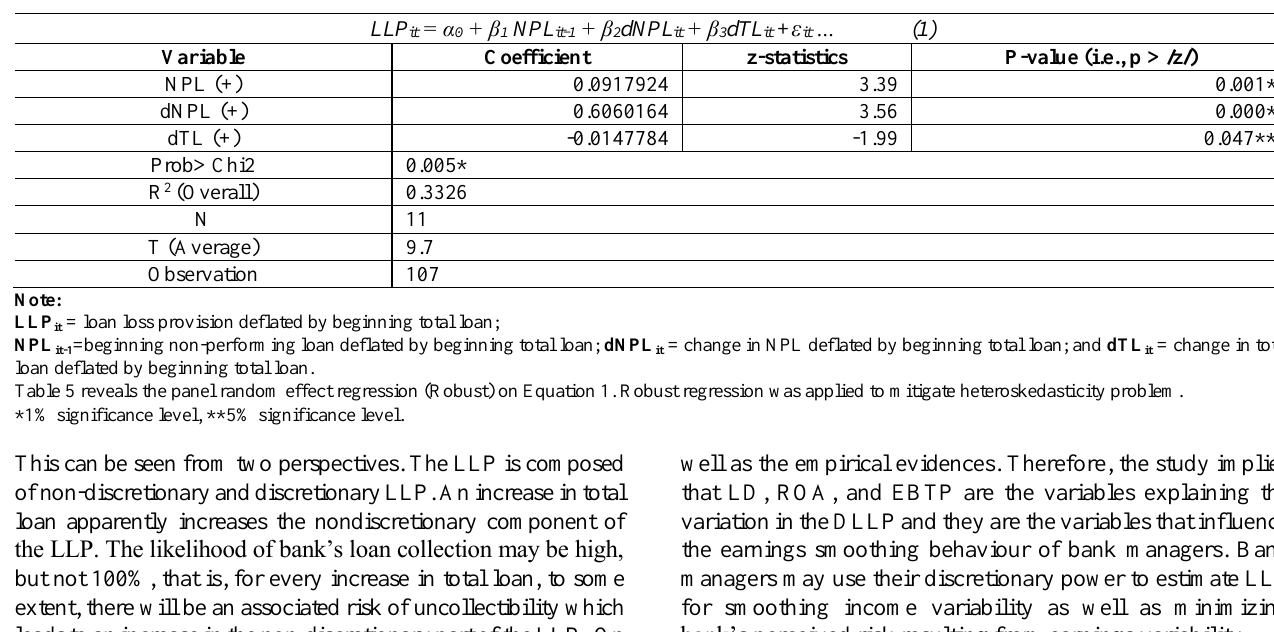
Table 5: Random effect regression